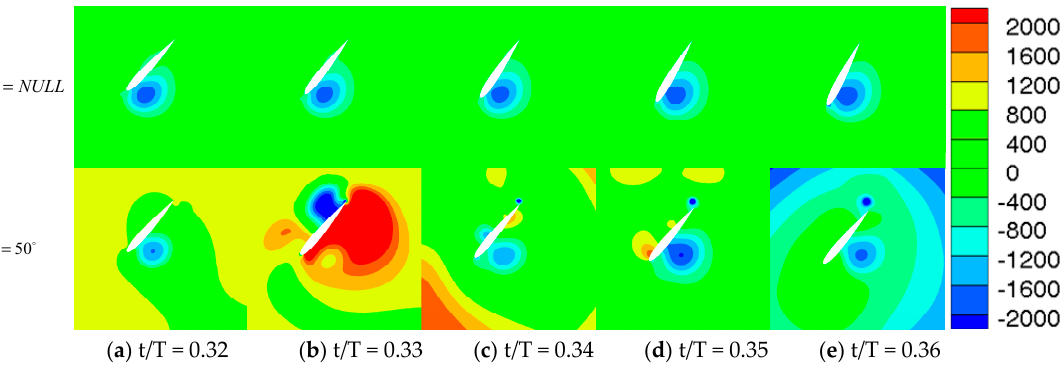
Figure 19. Instantaneous vorticity contours at t/T = 0.32 − 0.36 for different critical pitching amplitudes ( 𝜃 (cid:3030) = NULL and 𝜃 (cid:3030) = 50 (cid:2925) , ( a ) t/T = 0.32, ( b ) t/T = 0.33, ( c ) t/T = 0.34, ( d ) t/T = 0.35, ( e ) t/T = 0.36).